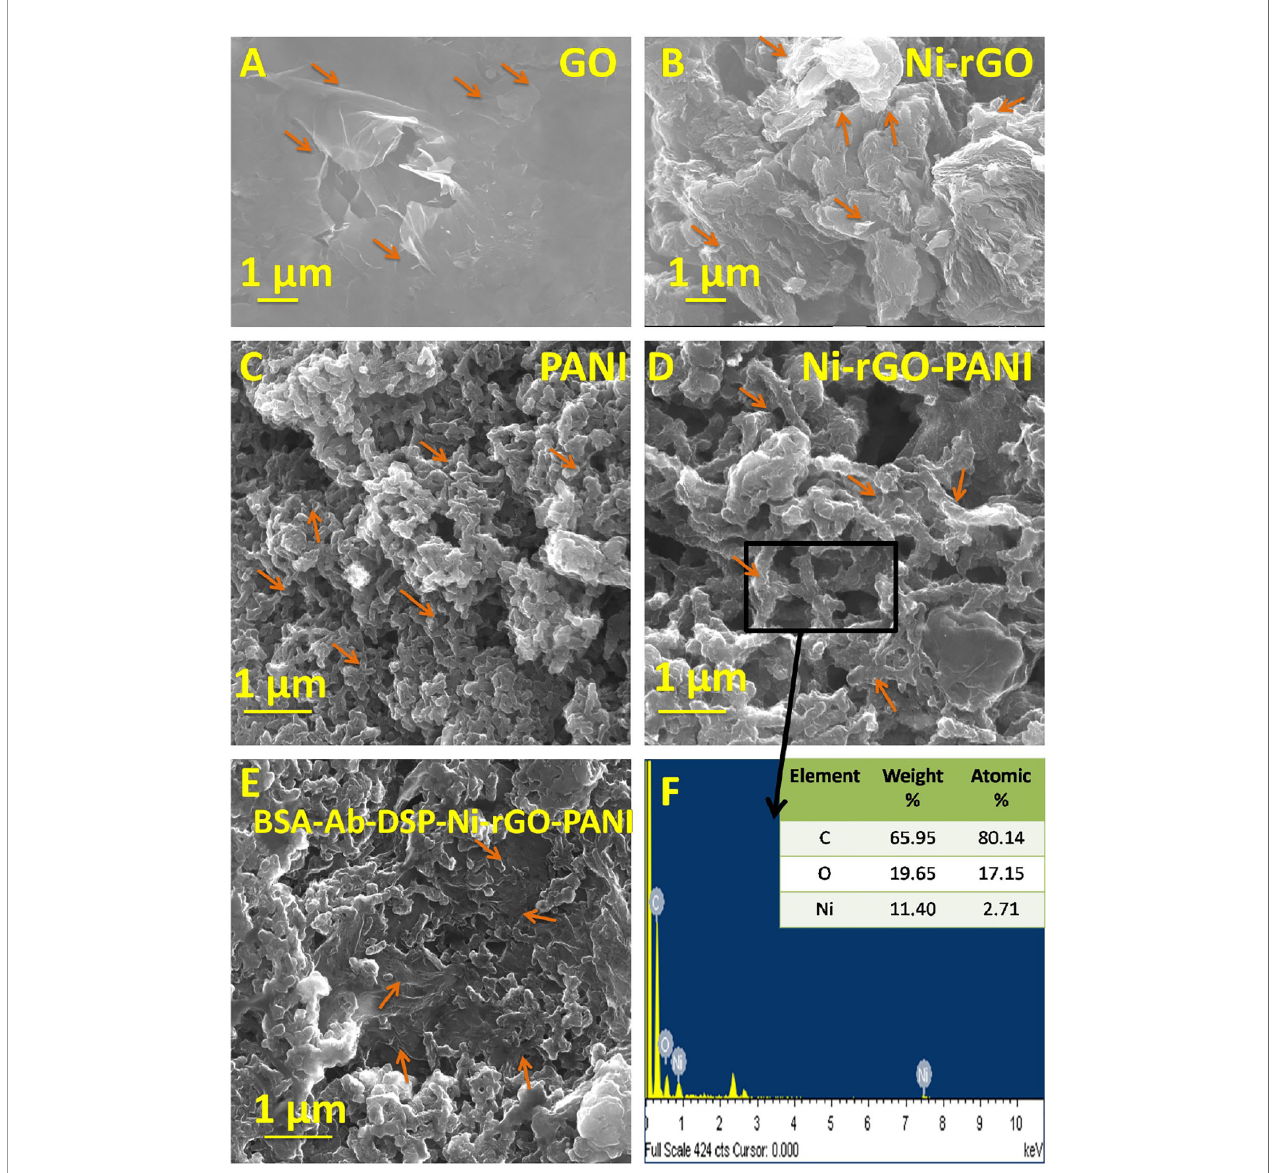
FIGURE 2 | SEM images of (A) GO, (B) Ni-rGO, (C) PANI, (D) Ni-rGO-PANI, (E) BSA-Ab-DSP-Ni-rGO-PANI, and (F) EDX spectra of Ni-rGO-PANI. The arrows indicate the speci fi c structures of the